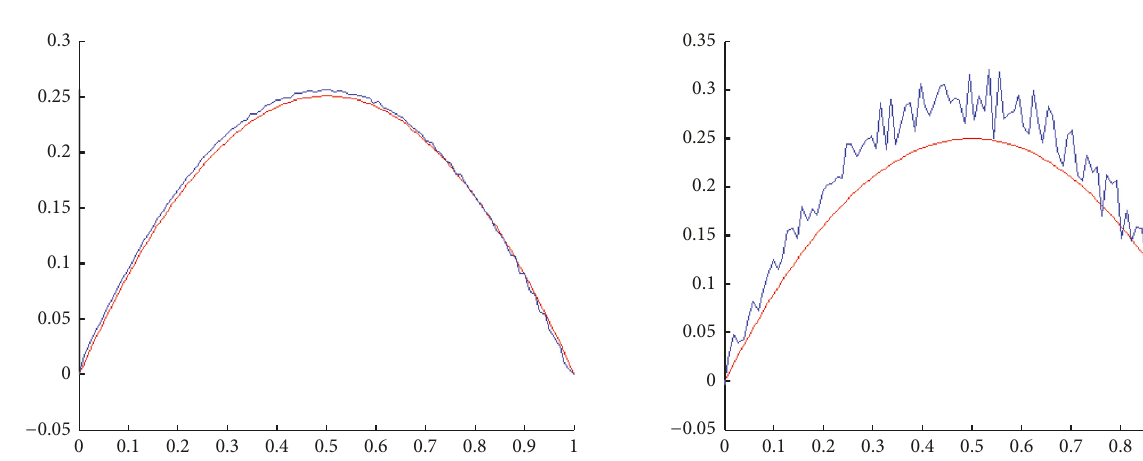
Figure 13: Initial temperature in err = 2% ‖𝜓 exact 0 ‖ 2 case. This figure shows that we can rebuild the true state.